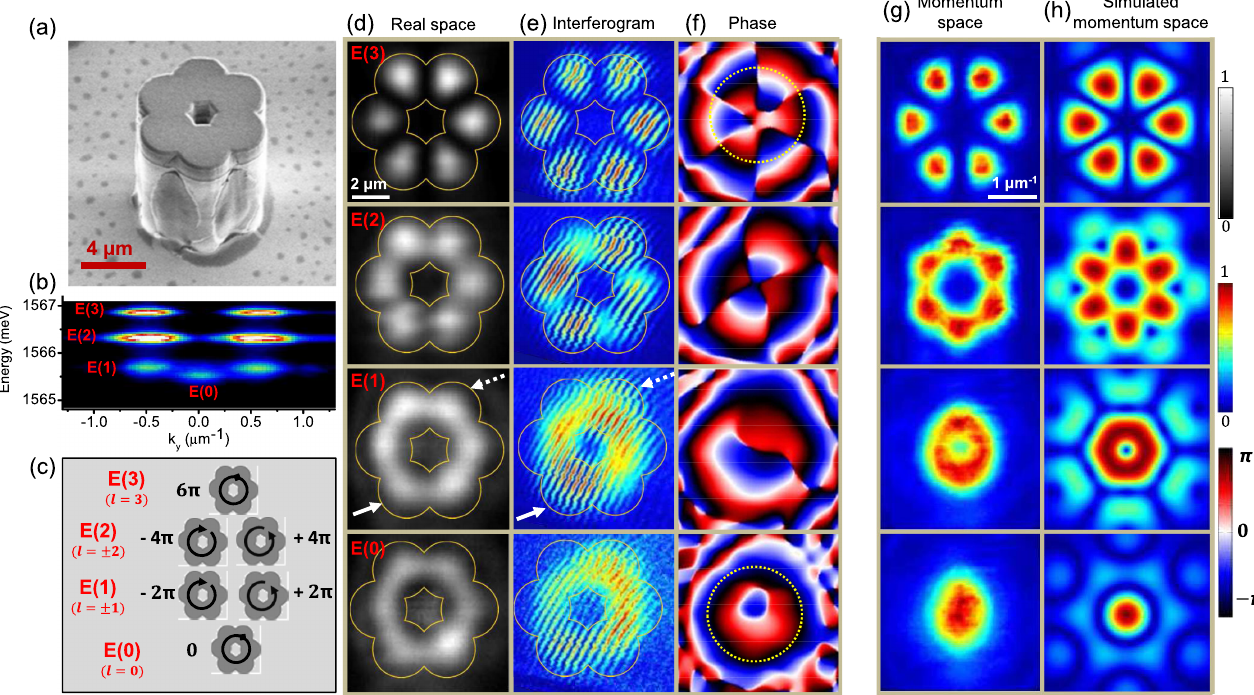
FIG. 1. Photonic molecular states. (a) Scanning electron microscope image of the polaritonic molecule. (b) Polarization-insensitive emissionspectrum in momentum space at k x ¼ 0 . 2 μ m andlow excitationpower(7mW),showingthe four molecular states E ð 0 Þ ; … ; E ð 3 Þ arising from the coupling of the lowest energy mode of each single micropillar. (c) Scheme of the phasewindingof the eigenfunctions of the E ð l Þ states without accounting for the spin. (d) Measured polarization-insensitive real-space emission. (e) Interference pattern and (f) extracted phase for each of the individual emission lines. The solid arrow points the pillar used for the phase reference in the interference experiment. (g) Measured polarization-insensitive momentum-space emission. (h) Simulated momentum-space emission obtained by Fourier transforming the tight-binding model eigenfunctions with a Gaussian distribution over each